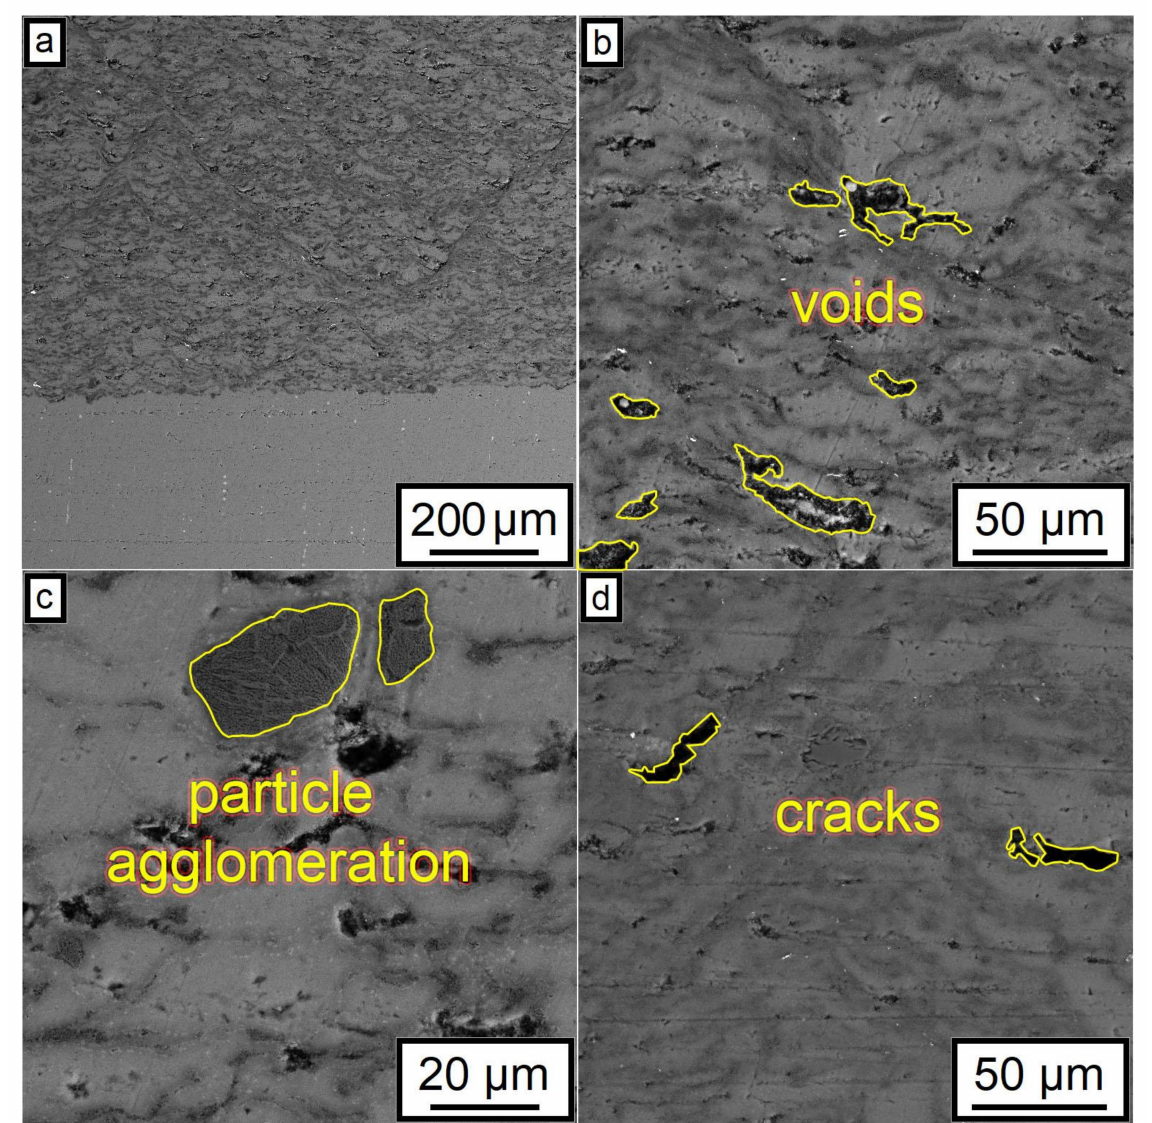
Figure 8. Typical defects of microstructure after CSM demonstrated using the 29% Al + 70% Al 2 O 3 + 1.0% CNF sample: ( a ) microstructure overview; ( b ) example of voids within coating microstructure; ( c ) example of particle agglomerations; ( d )